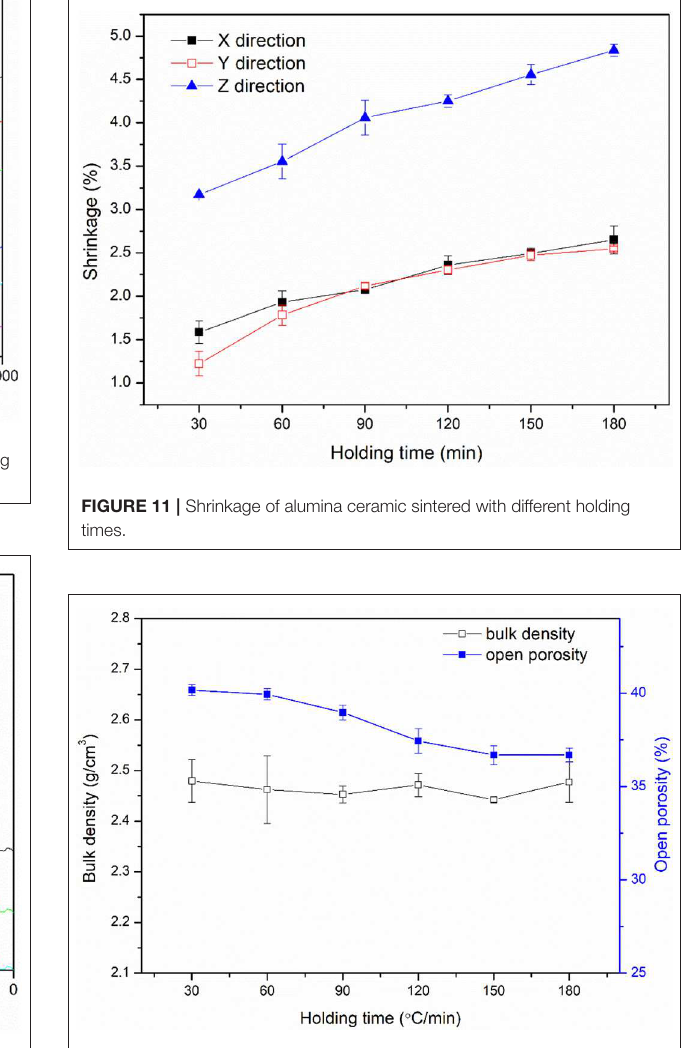
FIGURE 12 | Bulk density and open porosity of sintered alumina ceramic with different holding